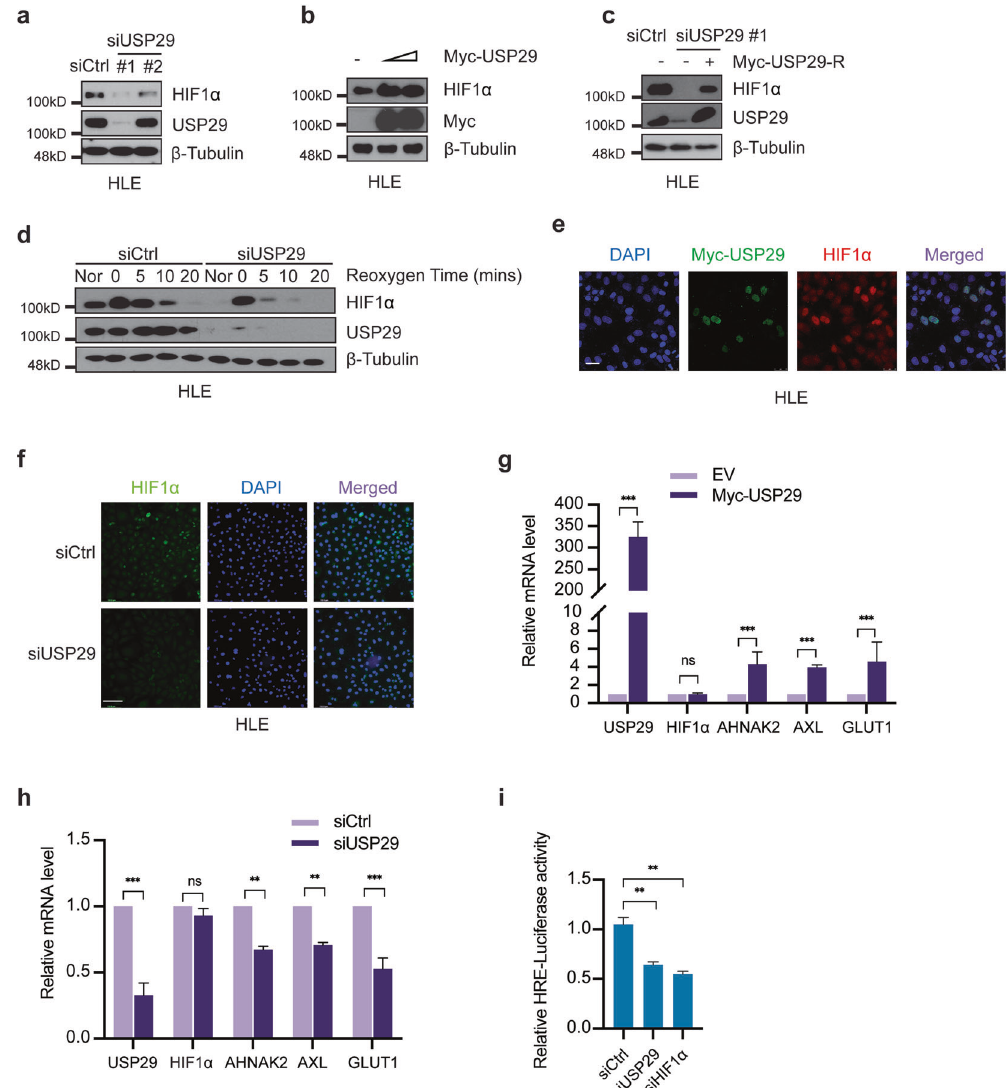
Fig. 2 USP29 stabilizes HIF1 α and promotes HIF1 α ’ s transcriptional activity. a Depletion of USP29 diminished HIF1 α protein levels in Sorafenib-resistant HLE cells. Two different siRNAs against USP29 (siUSP29#1 and siUSP29#2) were transfected into cells for the depletion